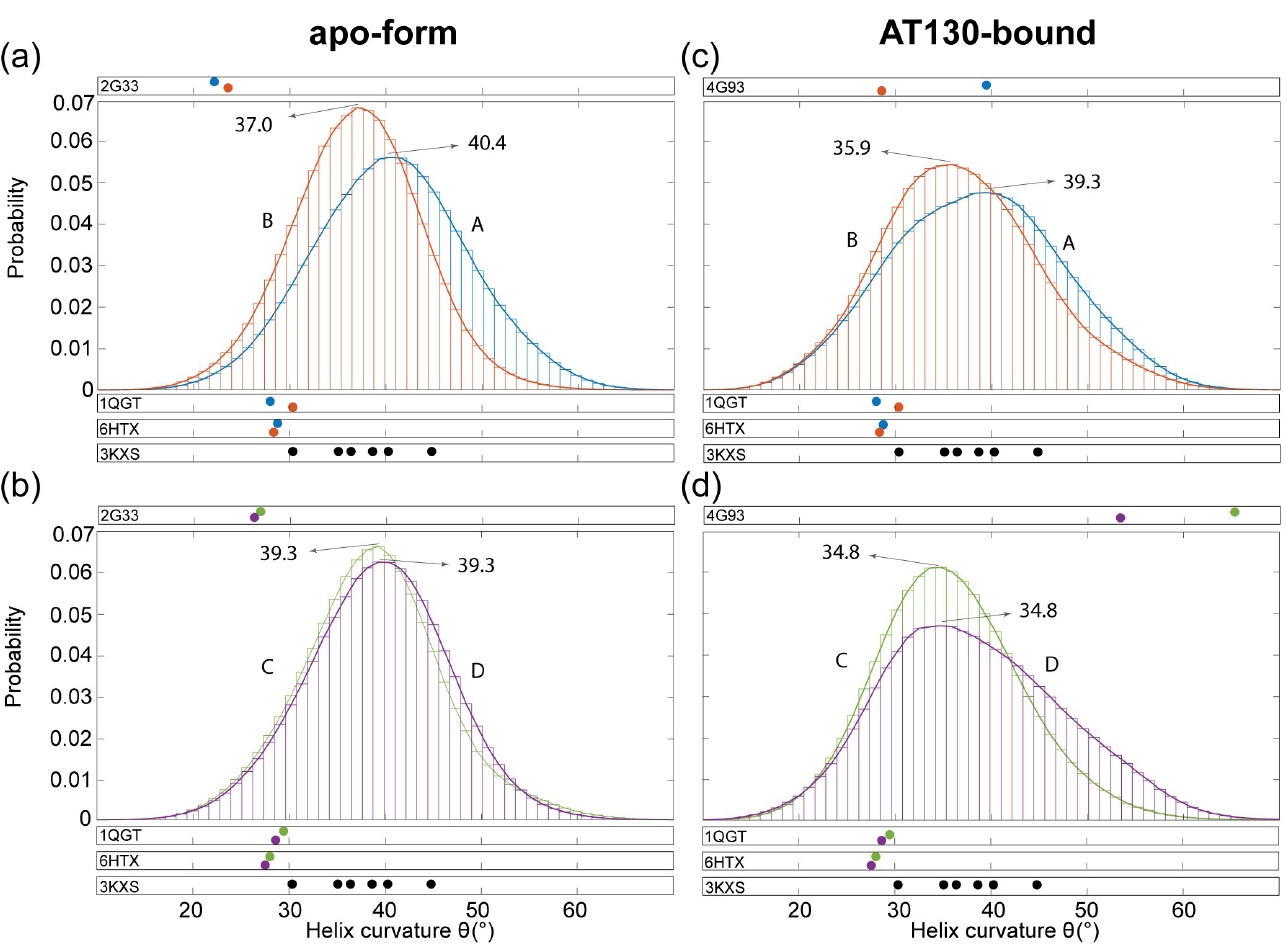
Figure 5. Hinge curvature analysis of capsid-incorporated dimers. ( a , b ) Distribution of angles for apo-form AB and CD dimers. ( c , d ) Distribution of angles for AT130-bound AB and CD dimers. Quasi-equivalent chains A, B, C, and D are colored blue, orange, green, and purple, respectively. Angles denote the curvature or deviation from linearity at the hinge vertex (Val93), measured with Bendix [37] along residues 88–98. Distributions calculated based on ensembles of three million conformers collected over 60 µ s of cumulative sampling, dividing data into 80 bins. Centers of distributions are indicated, and angles measured for relevant experimental structures are provided for reference. PDB 3KXS, 2.25 Å [11] describes a crystal of the assembly incompetent dimer, where the six resolved chains are not distinguished by quasi-equivalence. Distribution characteristics, including mean and standard deviation, are provided in Table